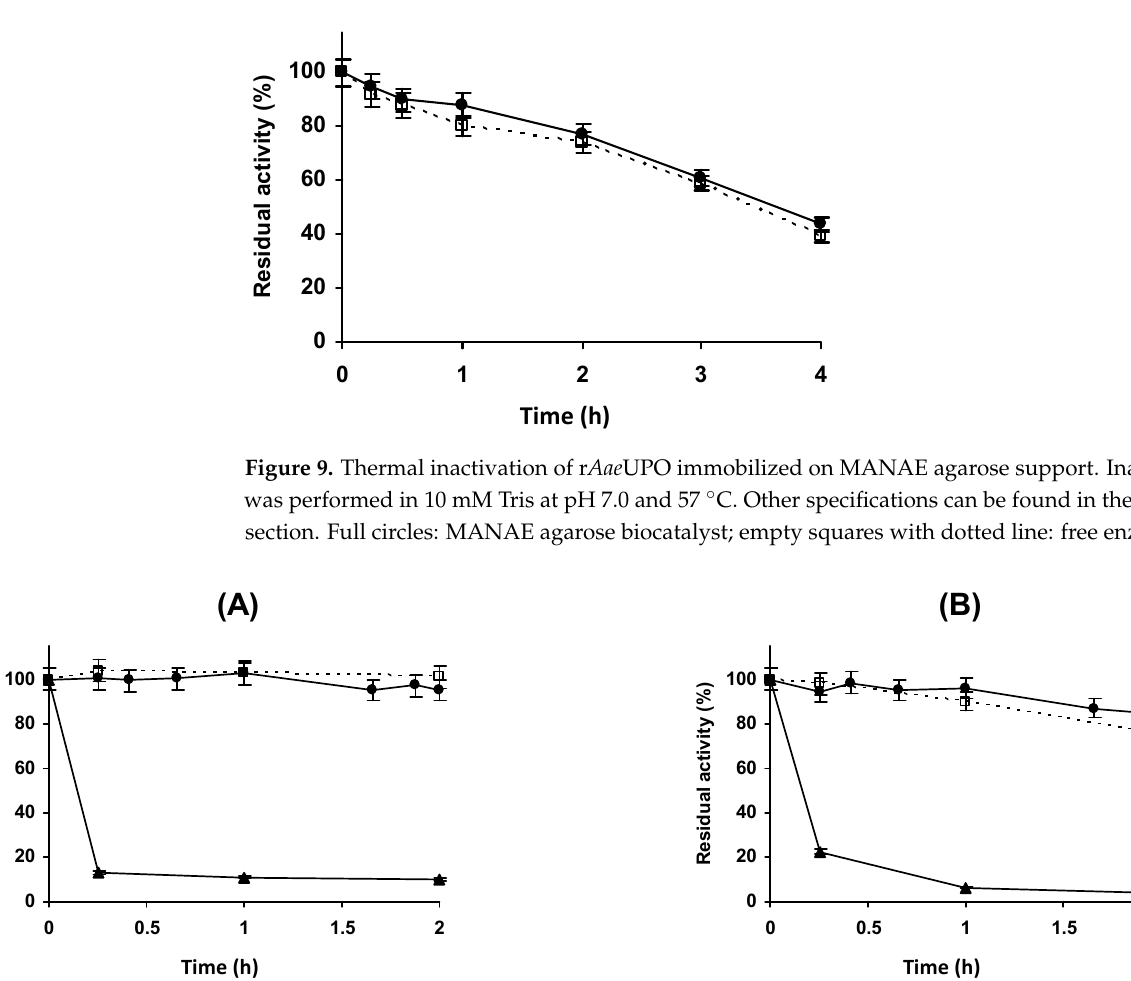
Figure 8. Immobilization courses of r Aae UPO at 25 °C and pH 7.0 on ( A ) MANAE agarose support, ( B ) PEI (10,000) agarose and ( C ) PEI (25,000) agarose. Other specifications can be found in the Methods section. Full circles: suspension; full trian- gles: supernatant; empty squares with dotted line: reference.